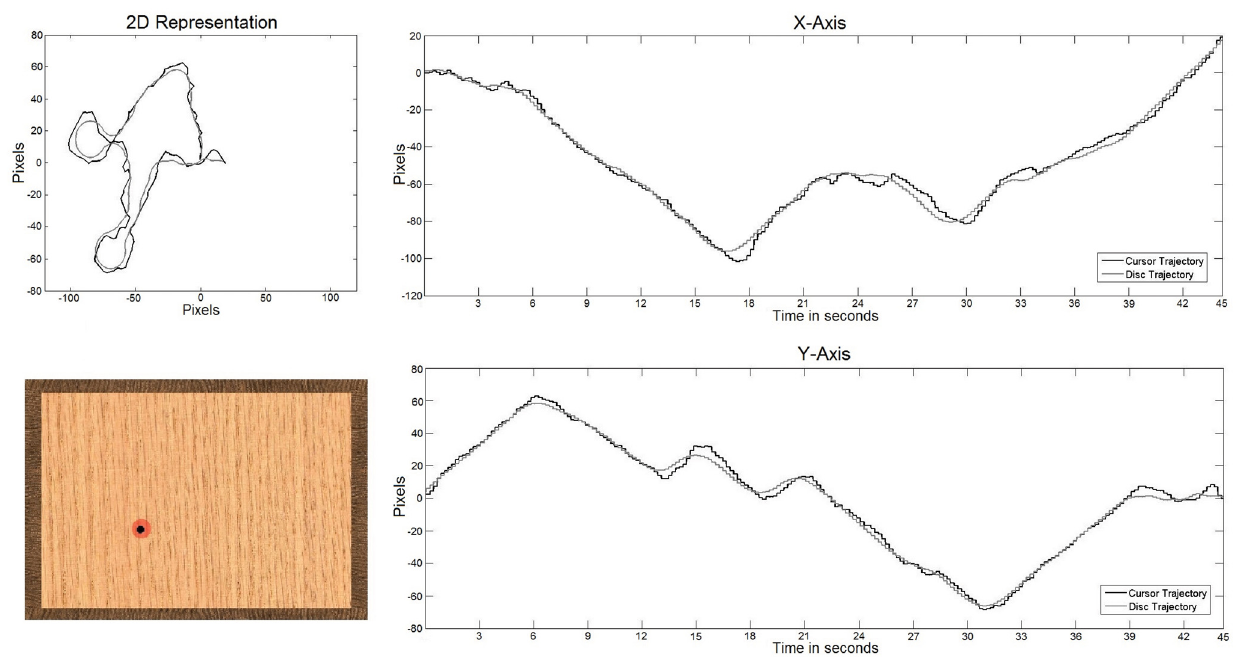
Fig 3. Example of the trajectory followed by the subject. 2D representation of the trajectory (top-left). X and Y axis trajectories (right). Appearance of the visual interface (bottom-left).